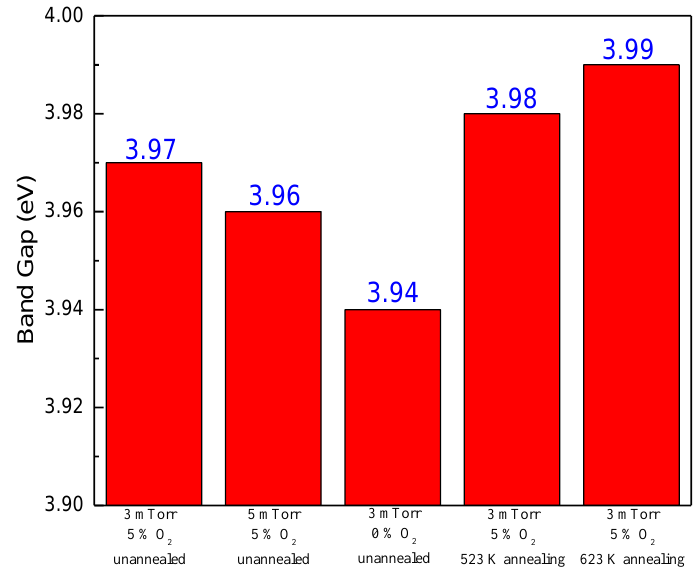
Figure 4. Band gap changes under different conditions.